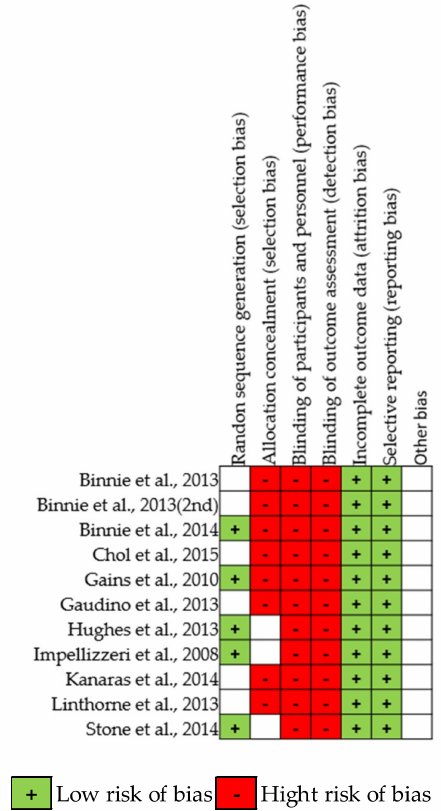
Figure 2. Risk of bias graph for each included study.